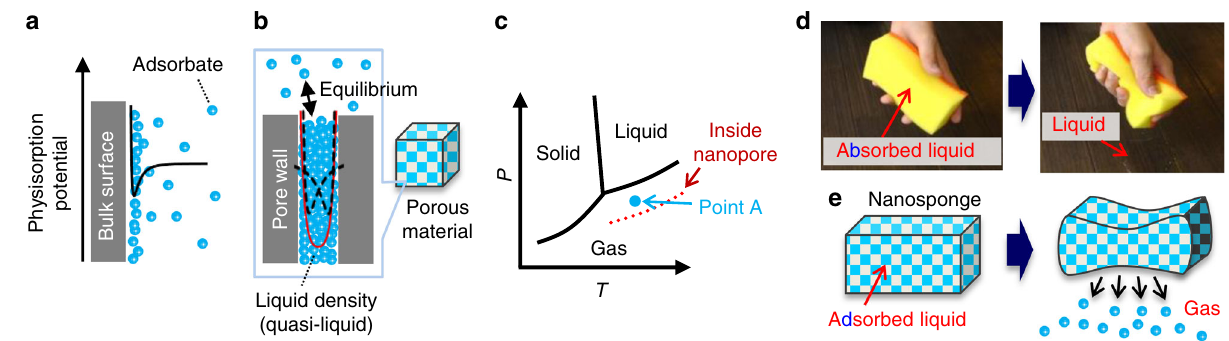
Fig. 1 Adsorption and liquid – gas phase transition. a Physisorption potential (black line) on a bulk surface. Blue spheres indicate adsorbate molecules. b Physisorption potential in a nanopore. Two potential curves (black dotted lines) afforded by two pore walls are combined into a deeper potential curve (red line). c A simpli fi ed phase diagram of refrigerant (H 2 O is assumed). The liquid – gas equilibrium line shifts downwards in nanopores, as shown by the dashed red line. d Photos of a plastic sponge absorbing liquid (left) and its squeezed state (right). e Illustration of nanosponge adsorbing quasi-liquid (left) and its